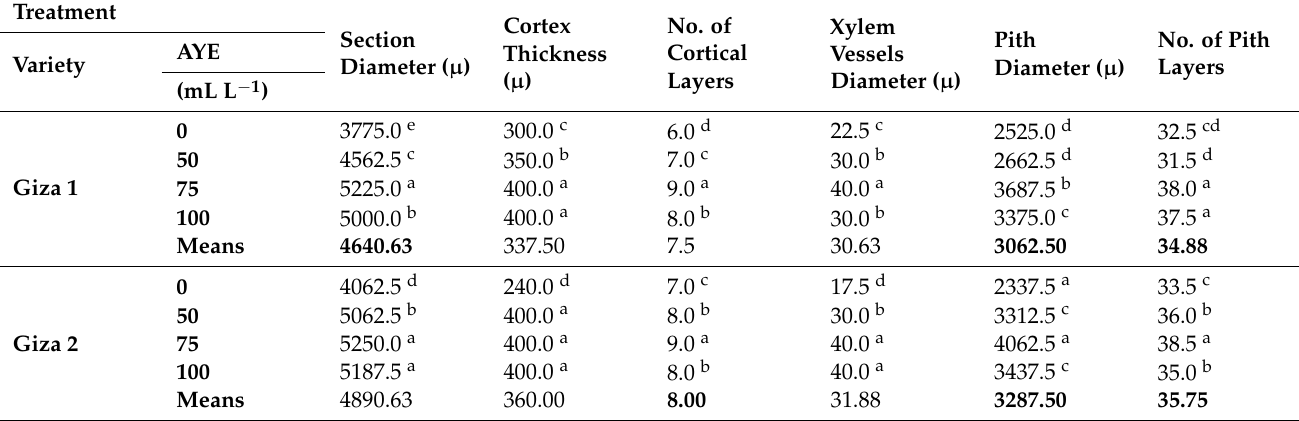
Table 3. Effect of four AYE exogenous applications on stem anatomy of two lupine cultivars grown in reclaimed-saline soil. Treatment